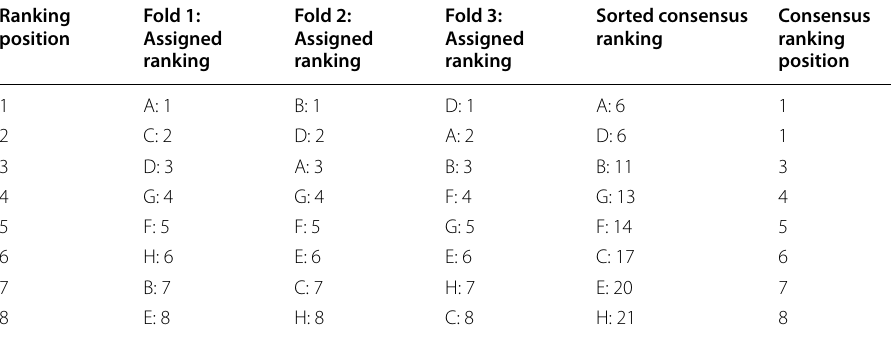
Table 1 Hypothetical example: Borda’s method with 8 features and three folds Ranking